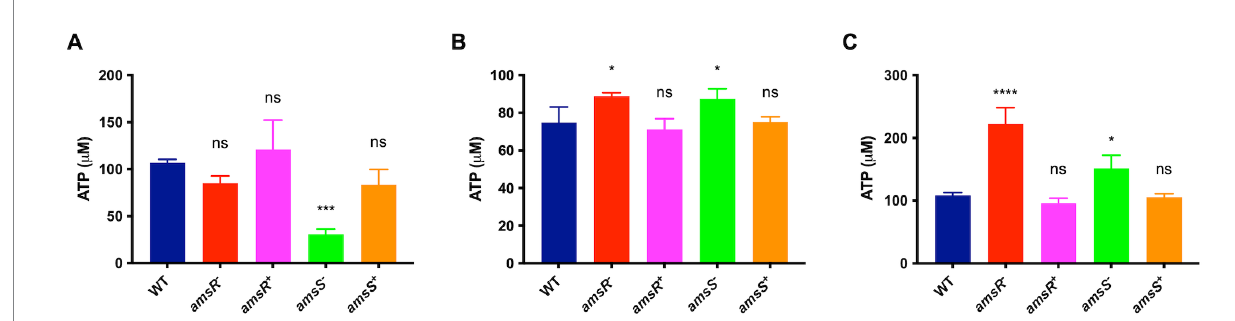
FIGURE 10 amsSR mutants favor ATP production via substrate phosphorylation. Intracellular ATP levels were measured in exponentially growing cells. Strains were grown in: (A) LB containing pyruvate (10 mM), (B) LB containing CCCP (6.25 μ g/mL), or (C) LB containing both CCCP (6.25 μ g/mL) and pyruvate (10 mM). Data is derived from three independent biological replicates. Error bars ± SEM. One-way analysis of variance, with Dunnett’s multiple-comparisons test, was used to assess statistical significance in comparison to wild-type, * p < 0.05, *** p < 0.001, **** p < 0.0001, ns, not significant.